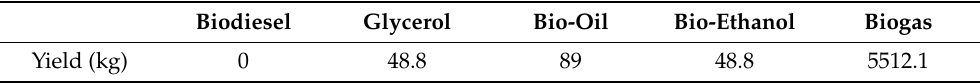
Table 1. The given yield of the desired products from the market demand in Scenario 1.